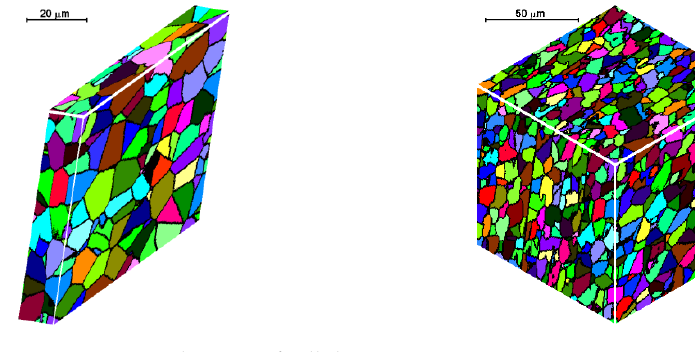
Figure 16. Straightening of cellular automata space.